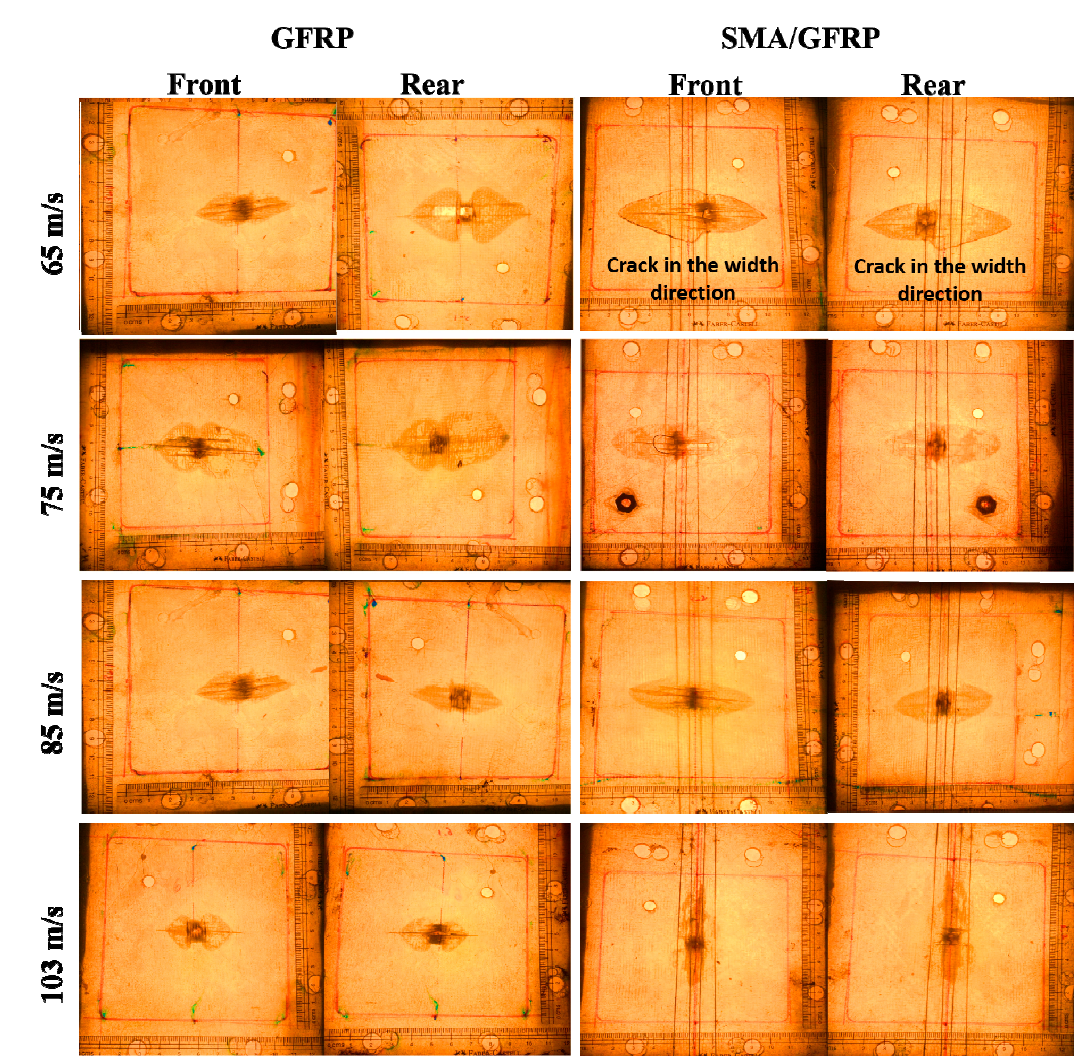
Figure 6. Damage visualization in GFRP and SMA/GFRP specimens (front and rear) at impact velocities 65 m/s, 75 m/s, 85 m/s and 103 m/s. Table 4. Total pull-out length for SMA/GFRP specimens at different impact velocities. Impact Velocities (m/s)